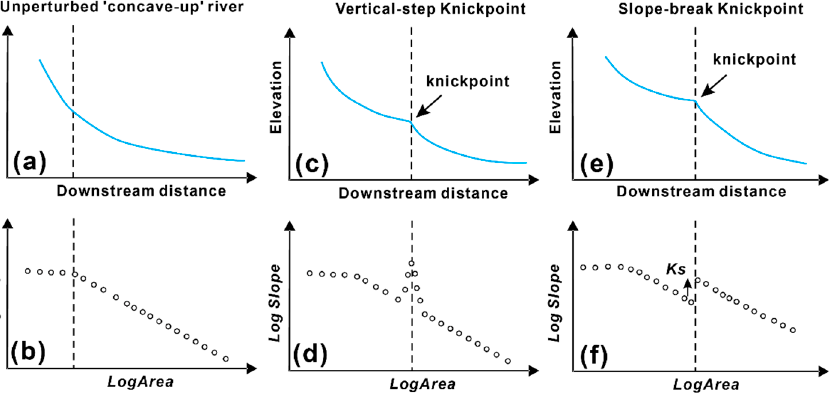
Figure 4. Schematic diagrams showing the river long profile knickpoint patterns and log-log slope-area plots. ( a , c , e ) The longitudinal profiles without knickpoint, with one vertical step knickpoint, and the slope break knickpoints, respectively; ( b , d , f ) The log-log slope-area plots corresponding to the longitudinal profiles, modified from [3,26,57].